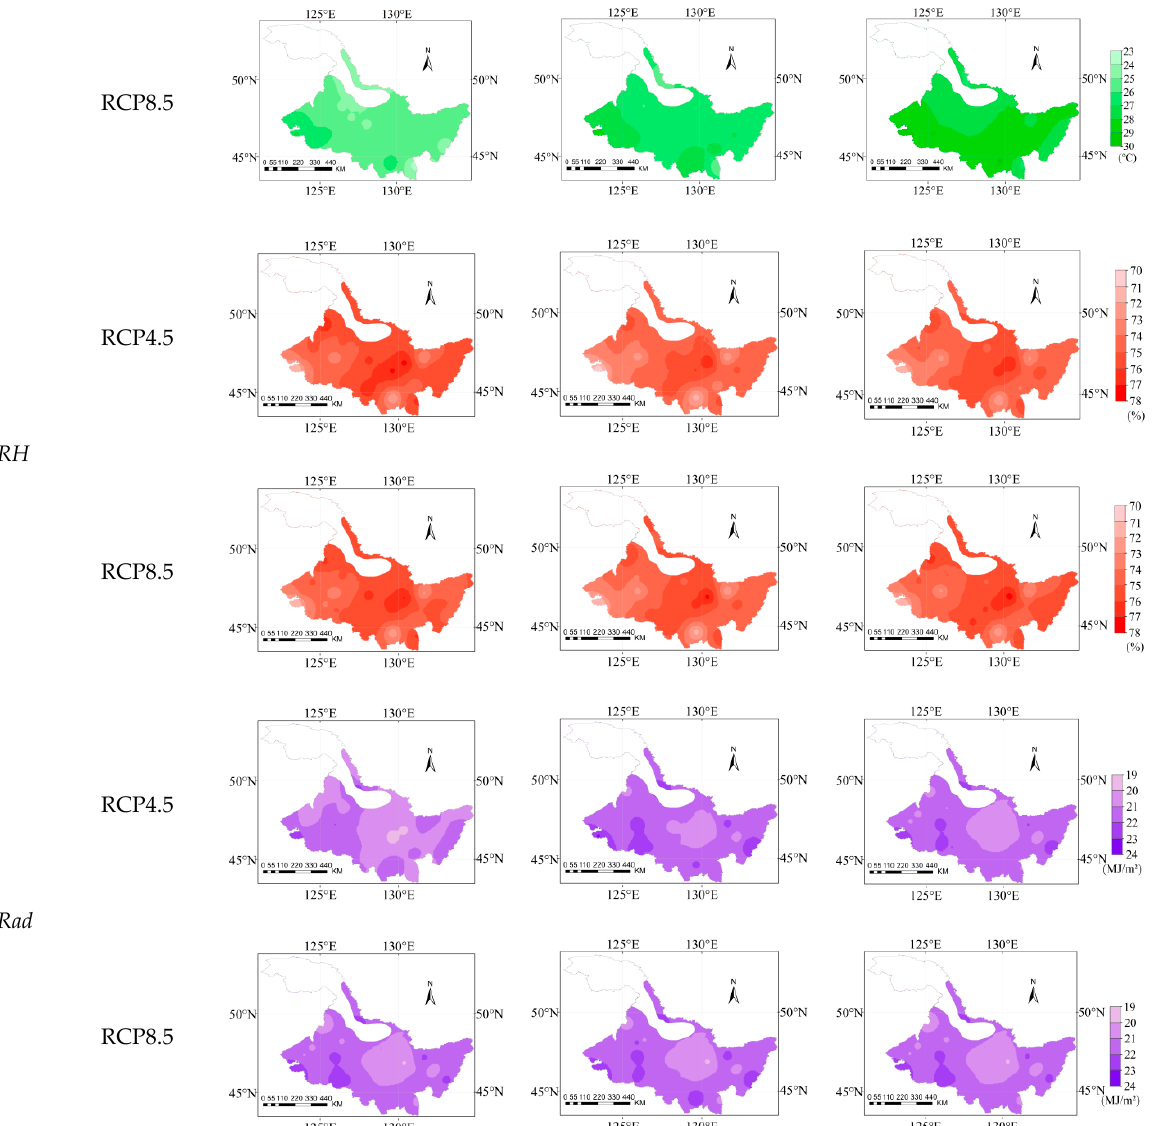
Figure 2. Spatial distribution of average minimum temperature ( T min ), maximum temperature ( T max ), relative humidity ( RH ), and solar radiation ( Rad ) during soybean growth period under RCP4.5 and RCP8.5 in the study area in the 2030s, 2050s, and 2070s.